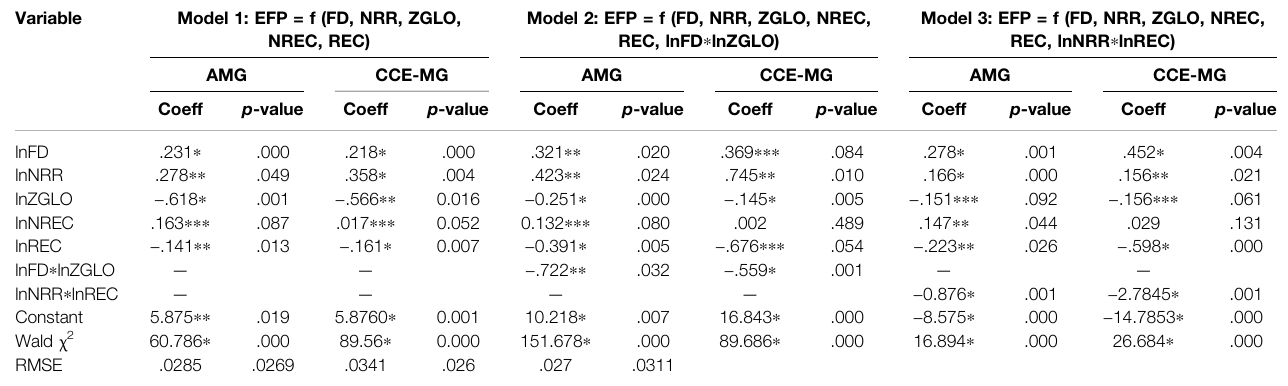
TABLE 8 | Results of long-run elasticity.